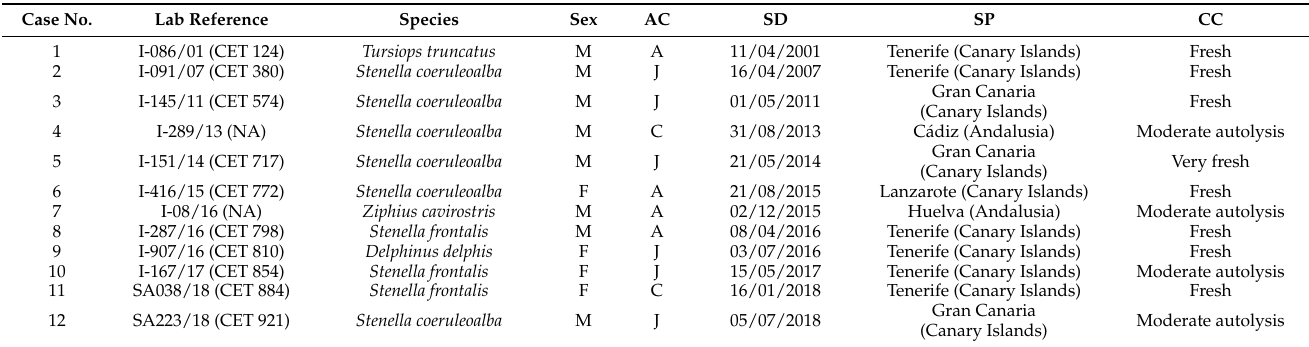
Table 1. Summarized data from the 12 animals with herpesvirus brain infections. F, female; M, male; AC, age class; A, adult, J, juvenile; C, calf; SD, stranding date; SP, stranding place; CC, carcass